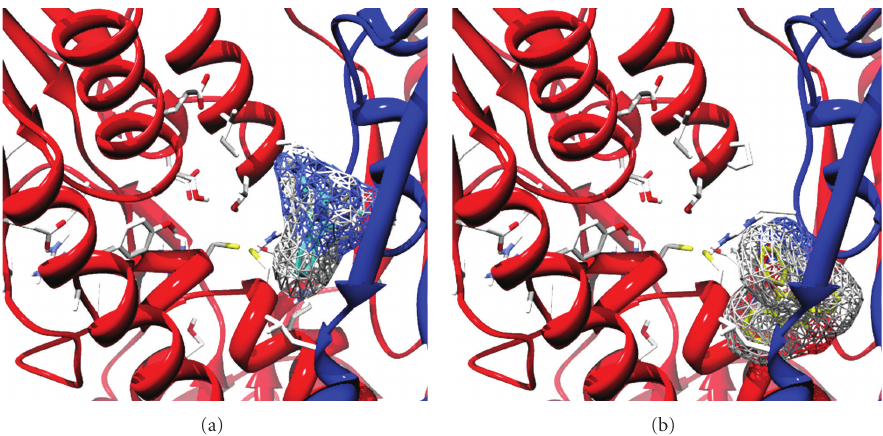
Figure 5: Binding Compound 31 (a) at the active site, the compound is lodged at the periphery of the active site, with potential hydrogen bonding interactions with Glu4666 and Glu467 making it a high-a ffi nity interaction. Compound 47 (b) belonging to Cluster 4 binds to the additional hydrophobic patch with side chains extending towards the substrate-binding cleft.